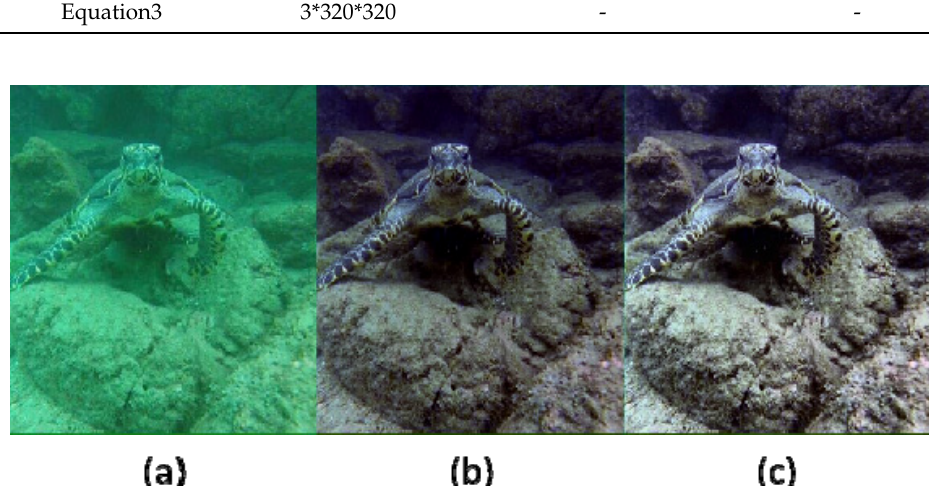
Figure 8. CLAHE algorithm. ( a ) Original underwater image; ( b ) after defogging, and ( c ) after CLAHE.